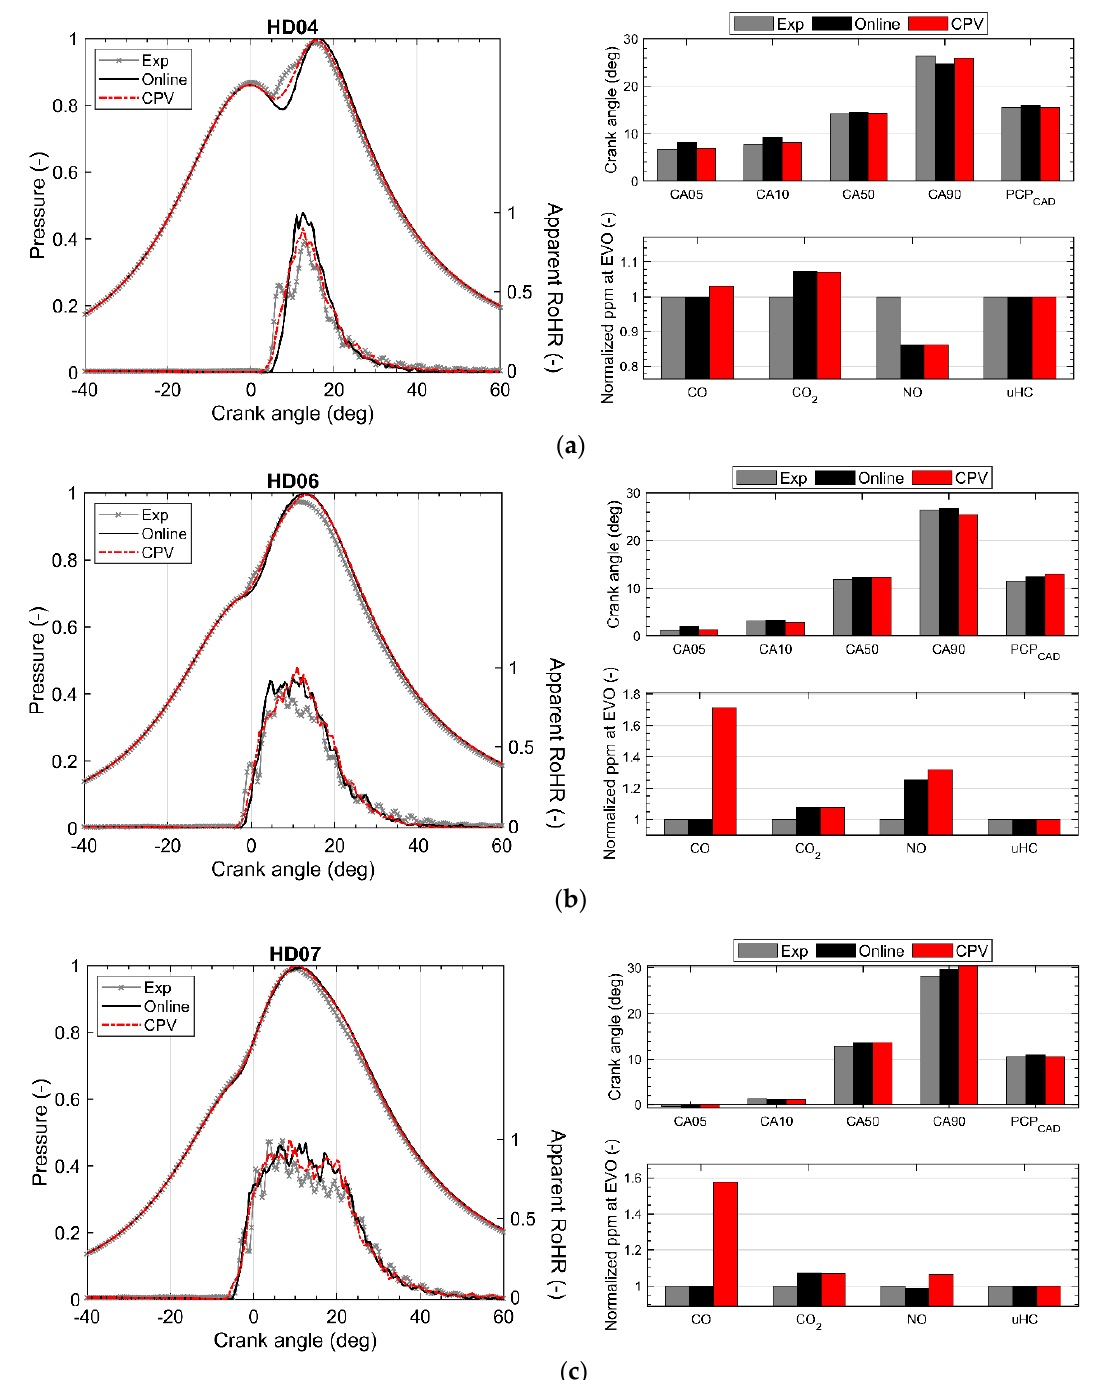
Figure 7. In-cylinder pressure history and apparent rate of heat release (left), combustion phasing parameters (top right) and normalized engine-out emissions (bottom right) comparisons between experimental data and SRM simulations for operating points ( a ) HD04, ( b ) HD06 and ( c ) HD07.